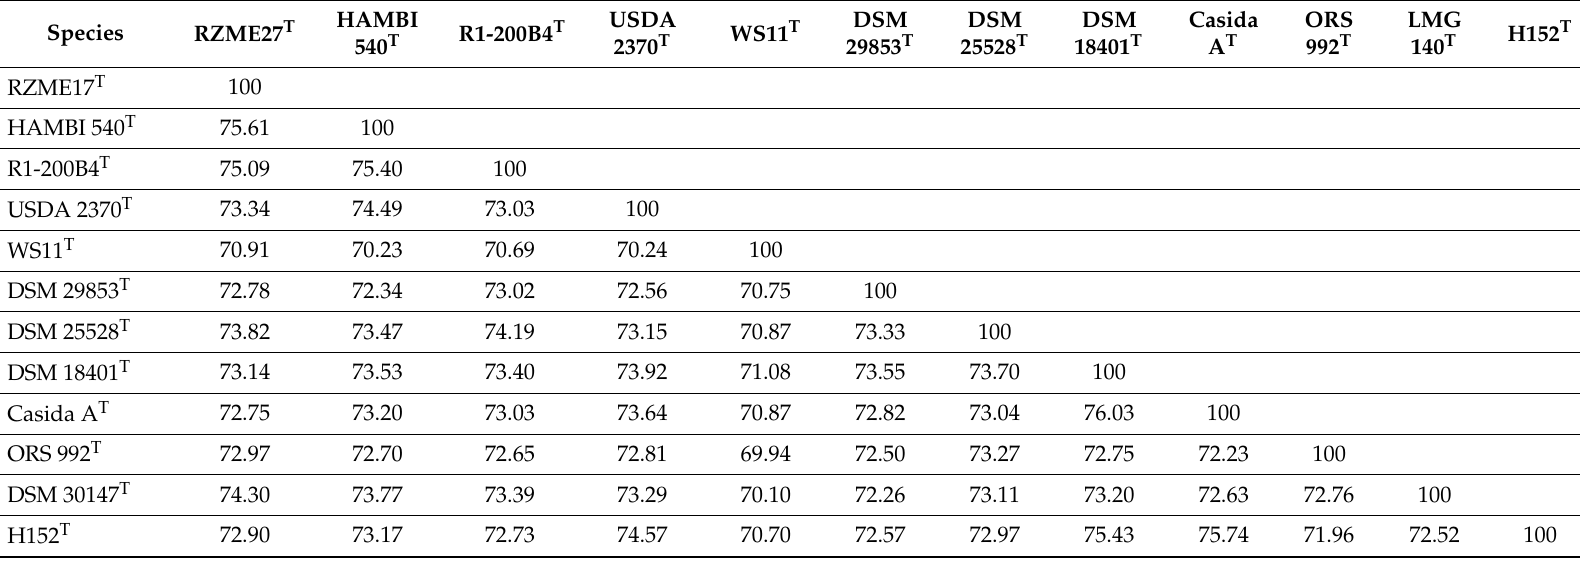
Table 2. Calculated ANIb values for available genomes of the type strains from the type species of the genera included in the family Rhizobiaceae (the accession numbers for these genomes are in parentheses). Endobacterium cerealis RZME27 T (WIXI00000000), Neorhizobium galegae HAMBI 540 T (HG938353.1),